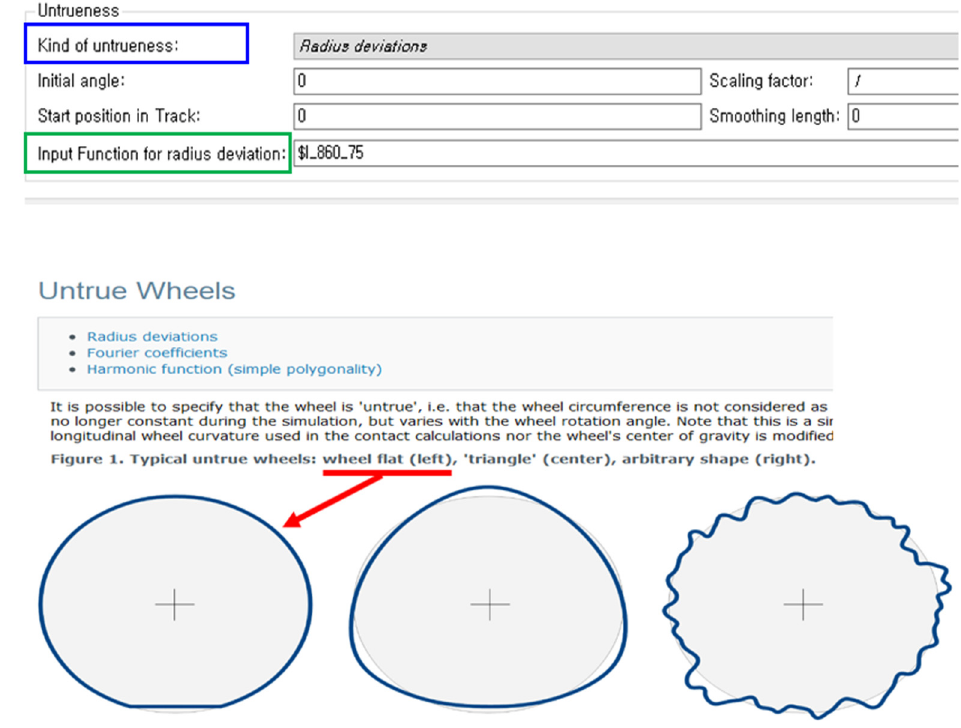
Figure 7. Modeling manual for wheel flat in SIMPACK [18].